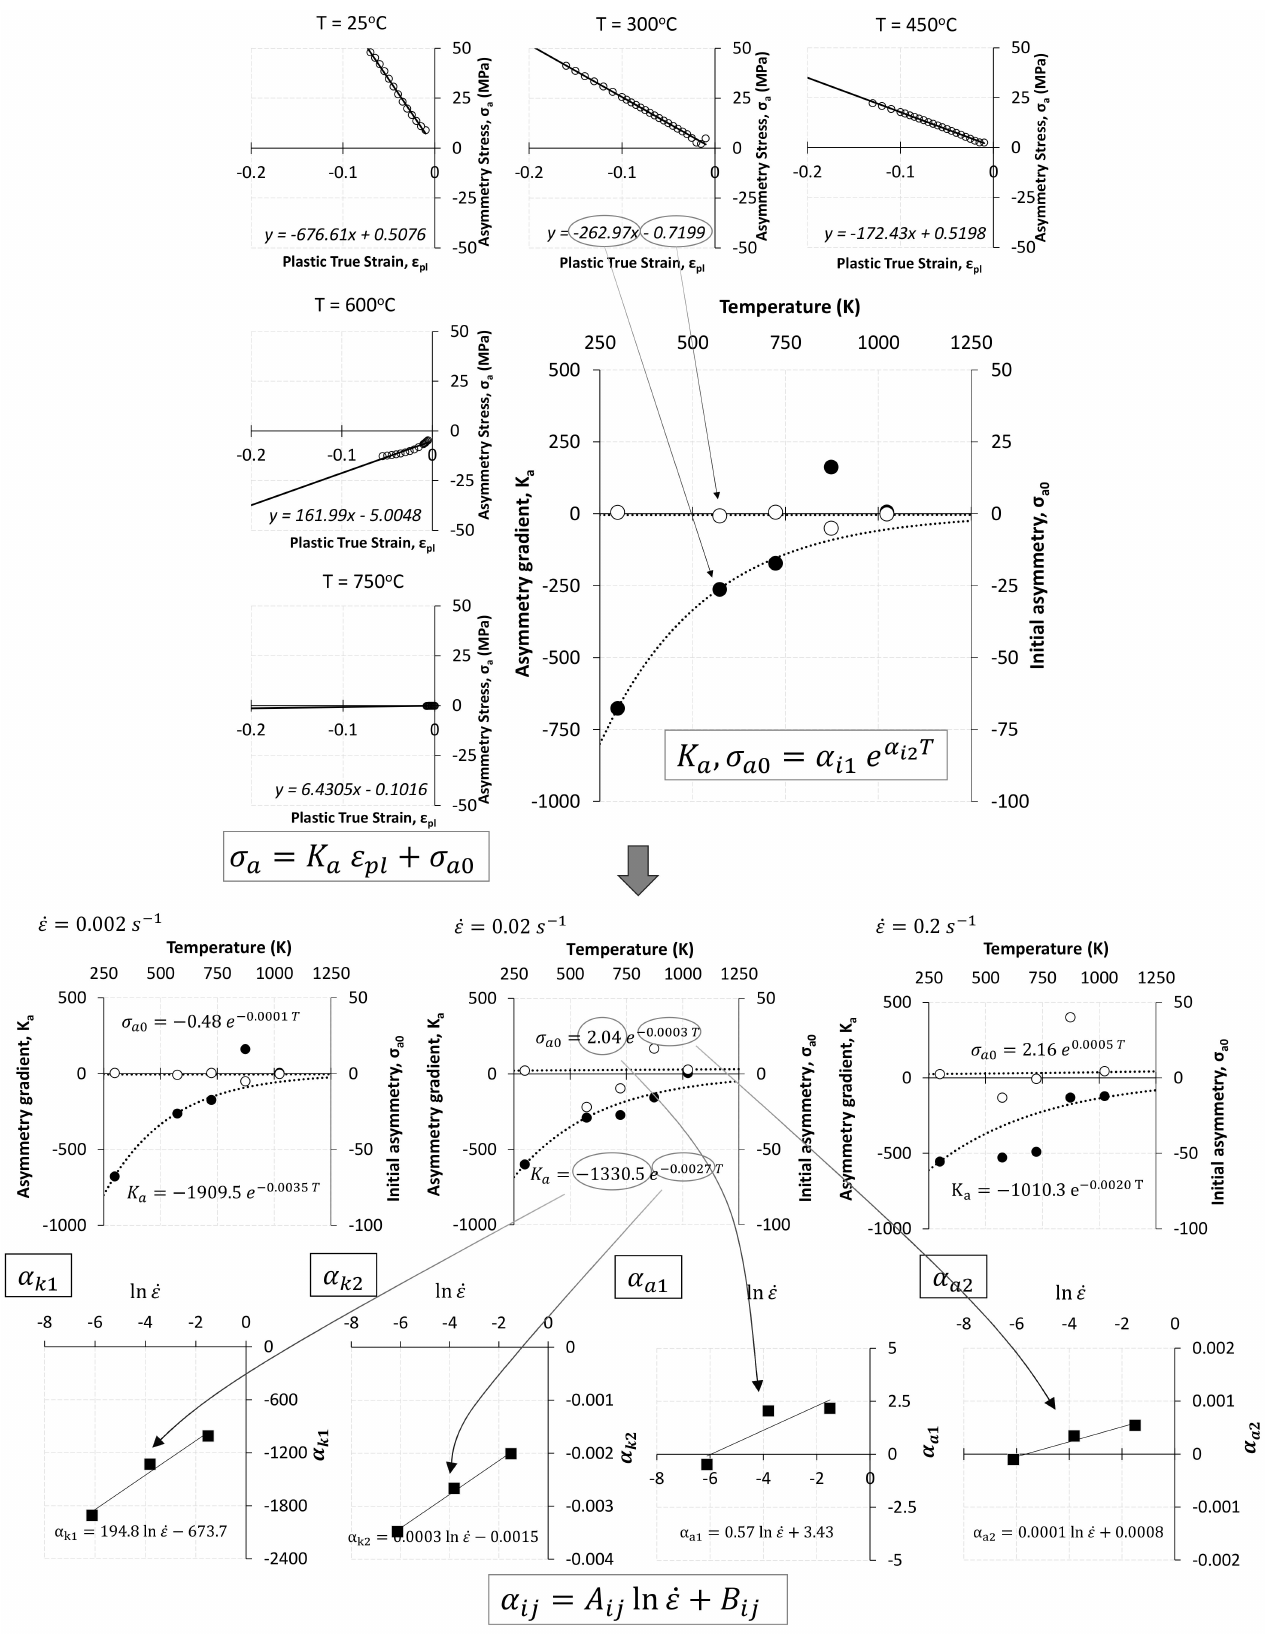
Figure 19. Development of the tension–compression (T-C) asymmetry model as a function of temperature and strain rate. Case: Ticp2 90 ◦